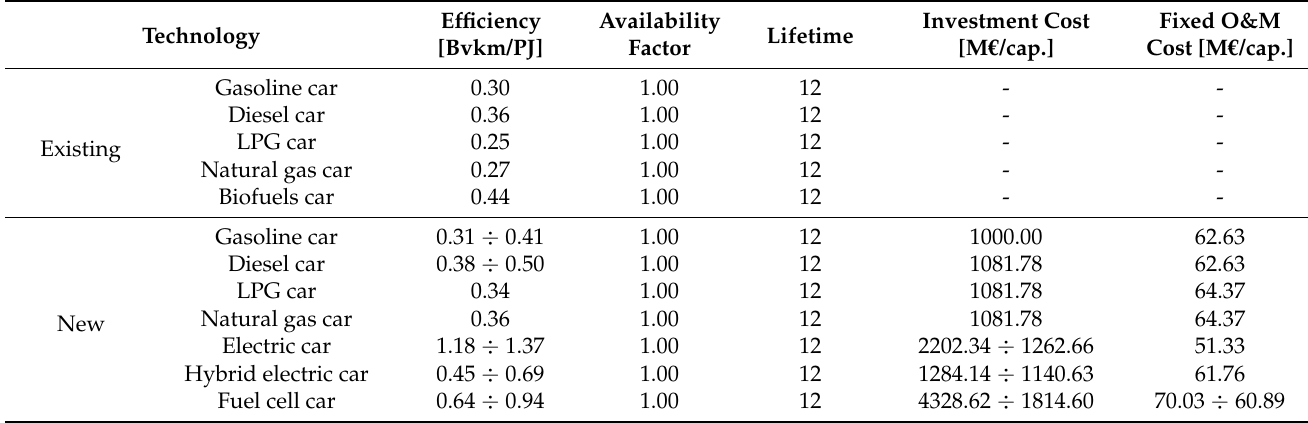
Table A3. Techno-economic characterization for road transport cars [13].